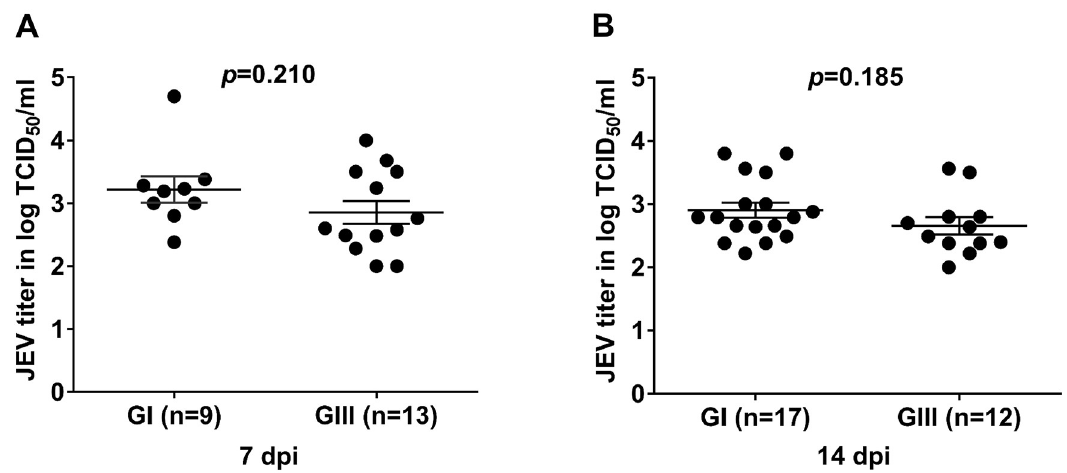
Fig 2. Viral titers in whole mosquitoes of JEV-infected mosquitoes. Cx . pipiens mosquitoes were orally infected with GI or GIII viruses and whole mosquitoes were collected at 7 dpi (A) and 14 dpi (B) for measurement of JEV titers by TCID 50 assay on BHK-21 cells. n , the numbers of mosquitoes tested positive for JEV. The p values were generated by Student t -test between GI- and GIII- infected groups. A p value of < 0.05 was considered significant.